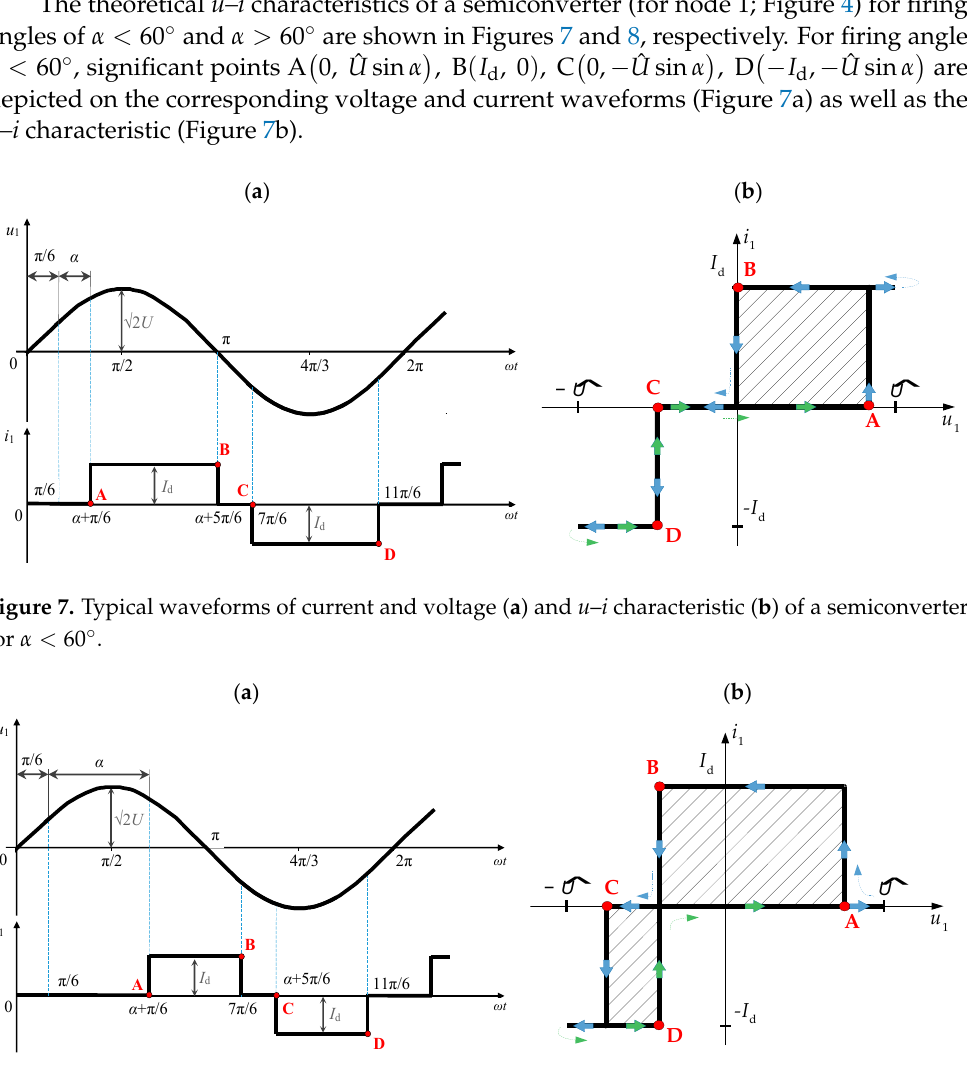
Figure 6. Typical waveforms of the mathematical model of a three − phase semiconverter with induc- tive load for ( a ) 𝛼 < 60° (six − pulse mode) and ( b ) 𝛼 > 60° (three − pulse mode).